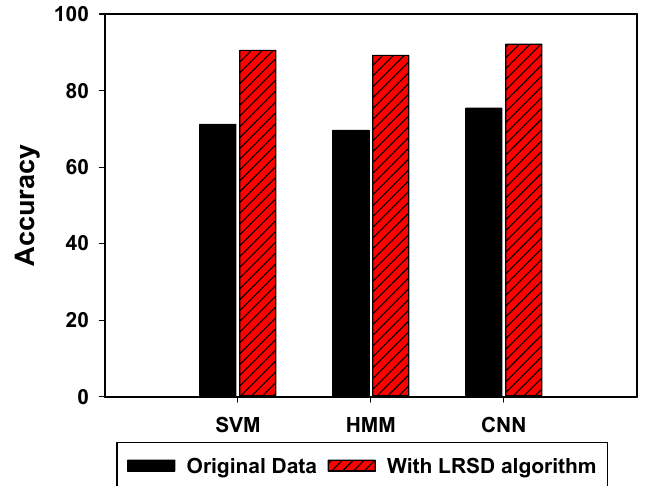
Figure 12. The performance of classifiers with different locations.